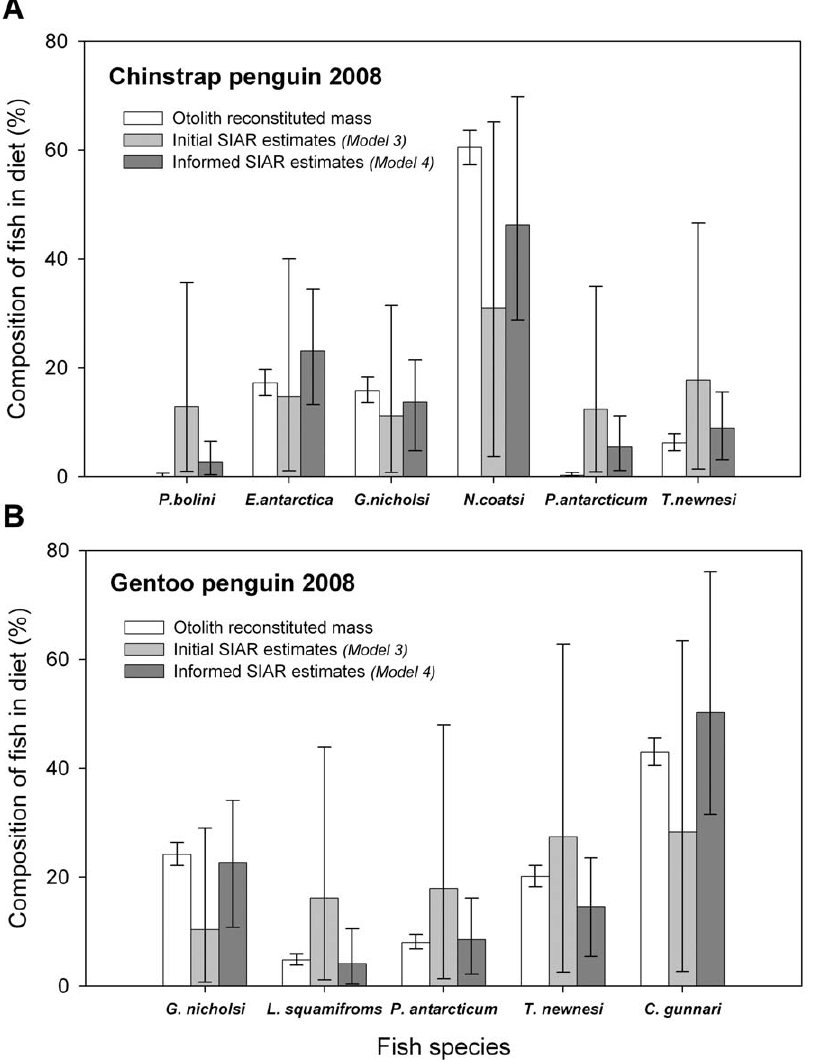
Figure 3. The fish species composition of penguin chick diets based on otolith and stable isotope analysis. Estimated dietary contributions exclude the krill portion of chick diets. Reconstituted mass derived from otolith measurements are compared with two variants (Models 3 and 4) of the SIAR multi-source Bayesian mixing model [21]. An initial model estimating the relative contribution of individual fish species identified from otoliths in stomach contents and an a posteriori informed model restricted to posterior draws agreeing with the relative abundance of each fish species by reconstituted mass (Tables S1 & S2). Estimates are presented mean 6 Bayesian 95% credibility intervals.